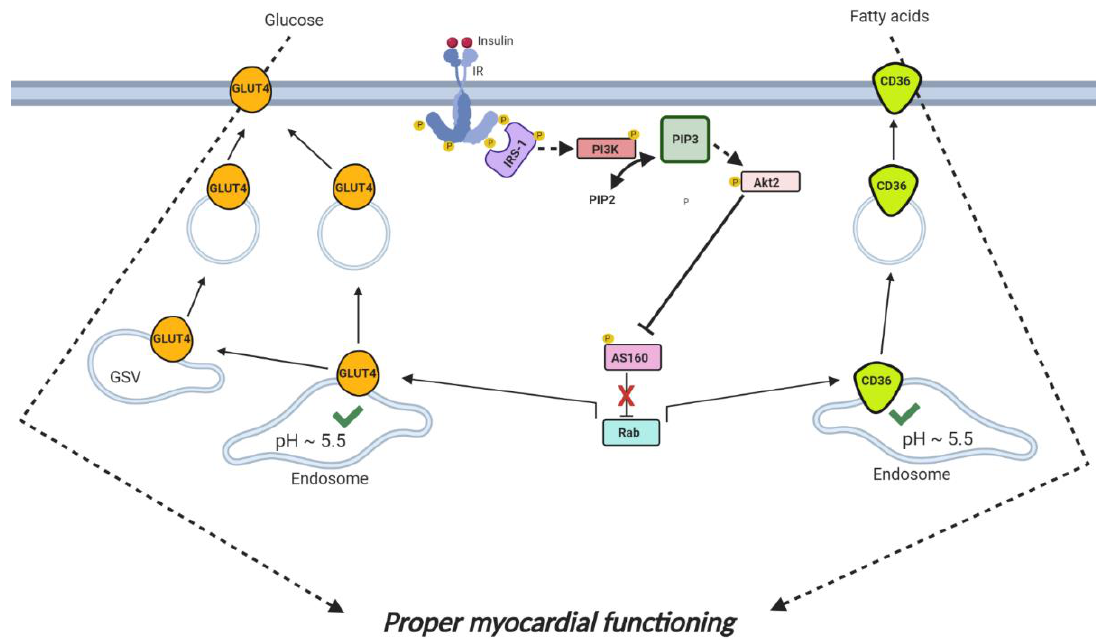
Figure 1. Cardiac insulin signaling pathway and substrate uptake. Binding of insulin to the insulin receptor (IR) stimulates IR autophosphorylation, which activates insulin receptor substrate-1 (IRS-1). Phosphorylated IRS-1 then stimulates phosphatidylinositol 3-kinase (PI3K) to convert the lipid metabolite PIP2 into PIP3, the activator of Akt2 kinase. Once activated, Akt2 performs inhibiting phosphorylation on RabGAP AS160, thereby de-inhibiting Rab proteins, which trigger the budding of vesicles containing GLUT4 (in orange) and CD36 (in light green) substrate transporters from the endosome. Budding of GLUT4 vesicles in response to insulin also happens from an additional GLUT4 intracellular storage compartment, namely GLUT4 storage vesicles (GSVs). Following vesicle formation, GLUT4 and CD36 will travel to the sarcolemma to mediate the uptake of glucose and (long-chain) fatty acids, respectively. The fusion between GLUT4- or CD36-containing vesicles and the sarcolemma is mediated by v- and t-SNARE proteins (not represented in the figure). The tuned subcellular recycling of these substrate transporter molecules to and from the sarcolemma translates into balanced glucose and fatty acid uptake rates, which is necessary for proper myocardial functioning.